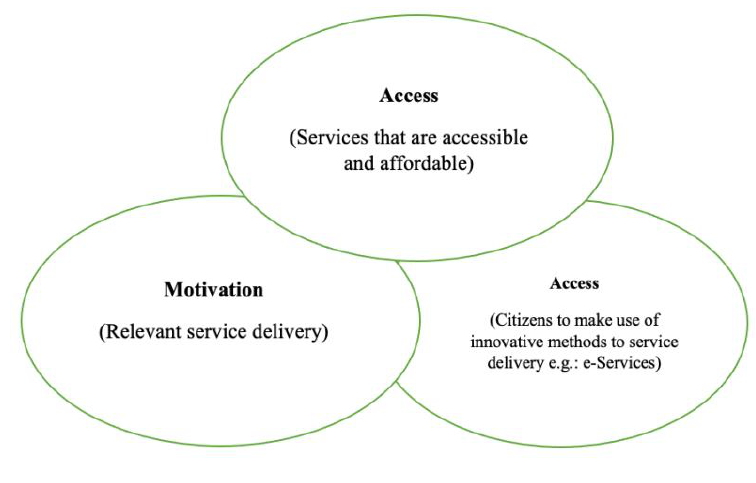
Figure 1: Encouragement through citizen centricity; Source: Adapted from Gupta